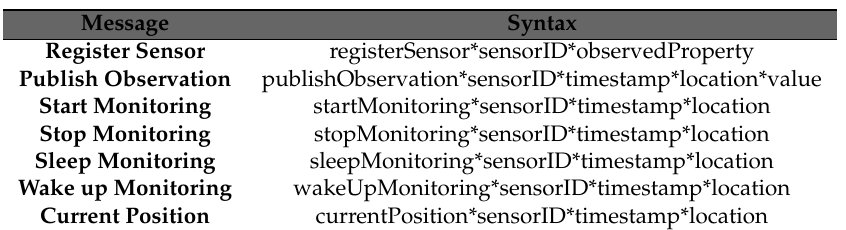
Table 2. Message